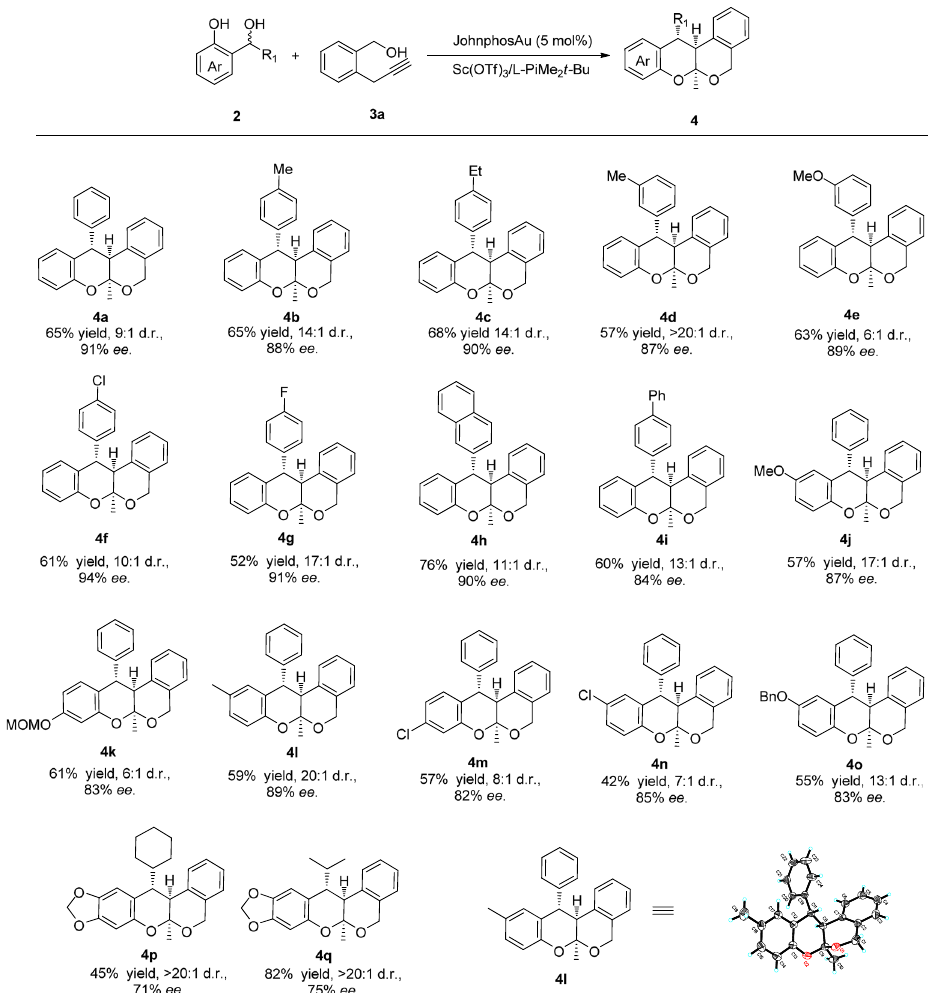
Fig. 3 Substrates scope of o -QMs. Unless otherwise noted, all reactions were carried out on a 0.2 mmol scale with 1.0 eq precursor of o-QMs 2 , 1.2 eq 3a , 10 mol% of Sc(OTf) 3 , 11 mol% of L-PiMe 2 t -Bu and 5 mol% of JohnphosAu in DCM (2.0 mL) under 6 °C. Isolated yield for major diastereomer. ee was determined by chiral HPLC. D.r. was detected by crude 1